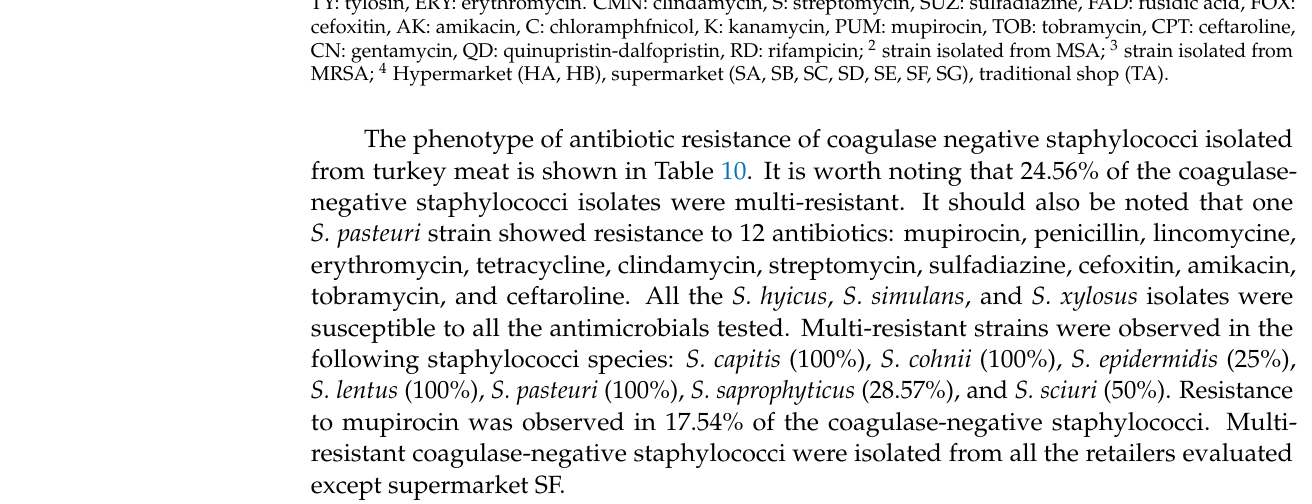
Table 10. Antimicrobial resistance phenotype of coagulase-negative staphylococci isolated from turkey